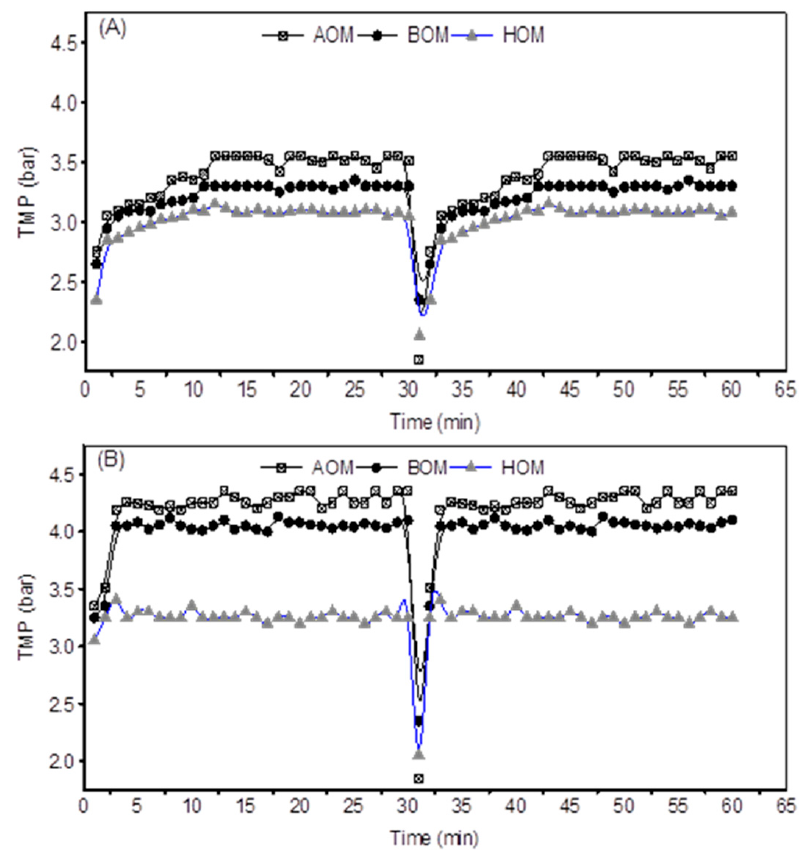
Figure 2. TMP comparison for 50 kDa ( A ) and 5 kDa ( B ). Each filtration experiment was duplicated, and the variation of two experimental data sets are within 10%.